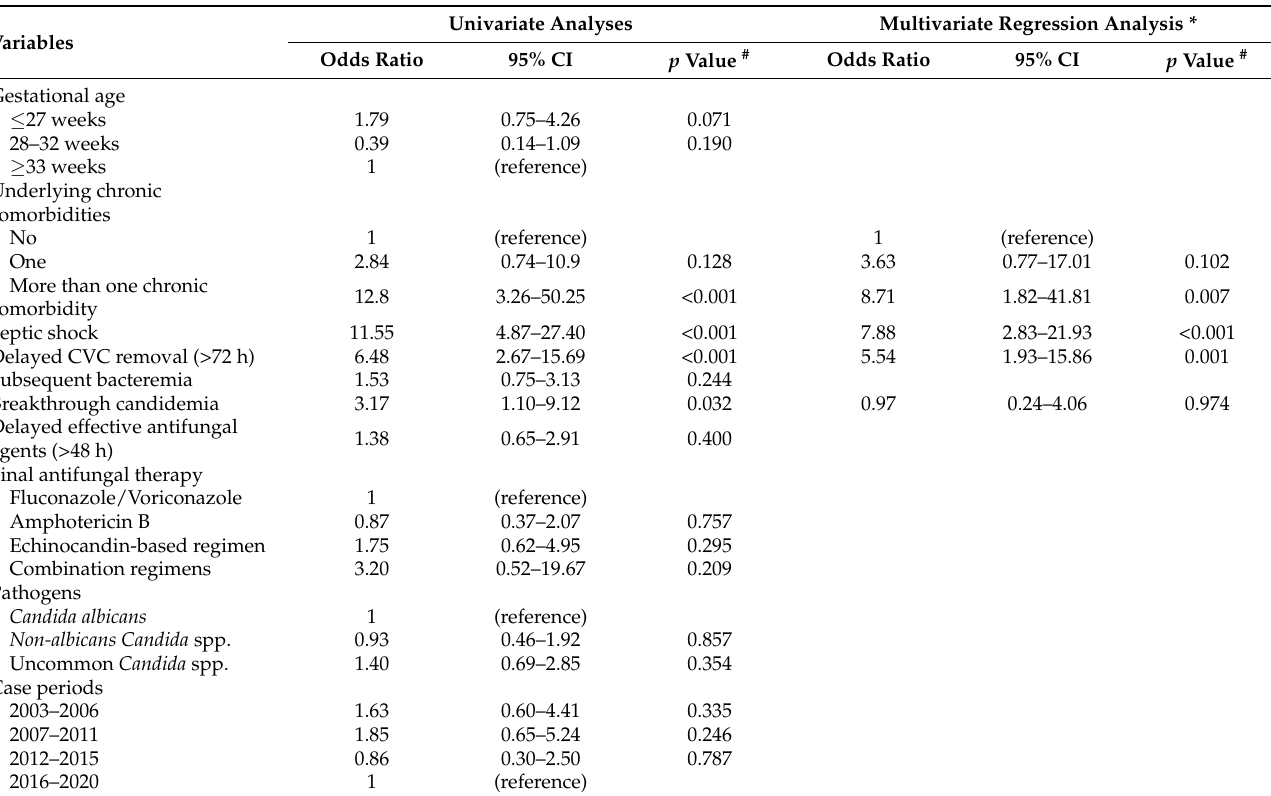
Table 4. Univariate and multivariate logistic regression analysis for independent risk factors of final in-hospital mortality in neonates with